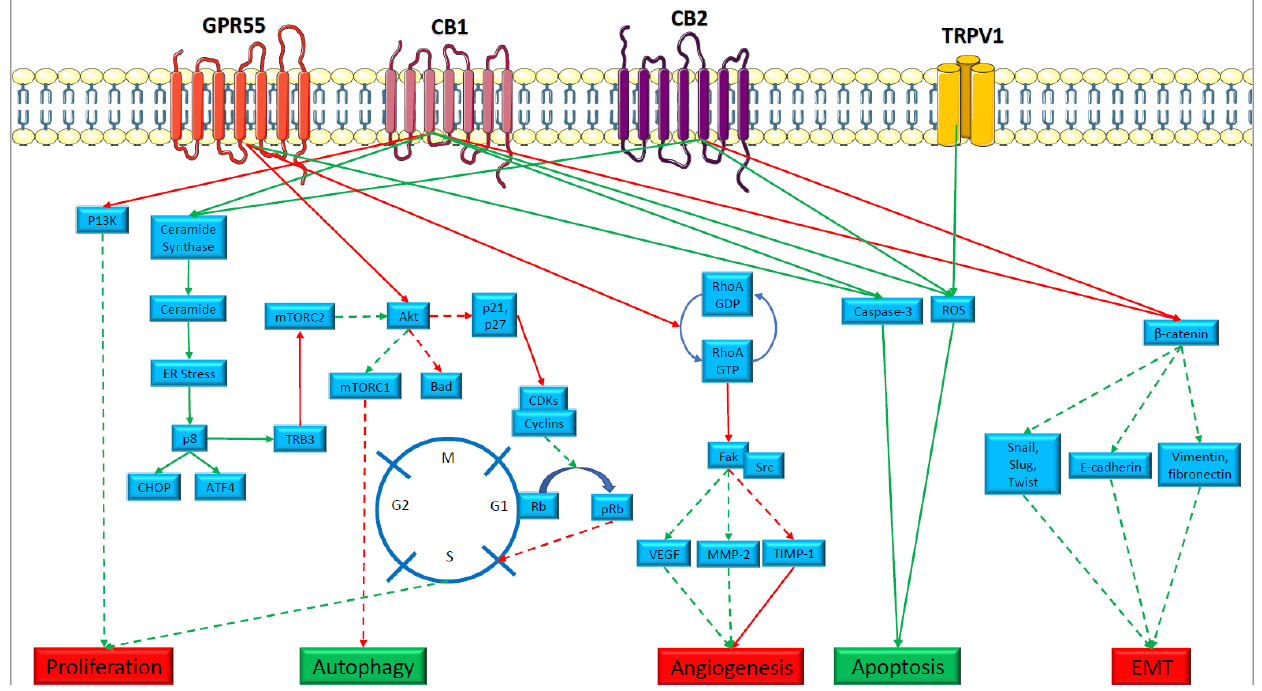
Figure 1. The mechanisms by which cannabinoids have anti-cancer effects.